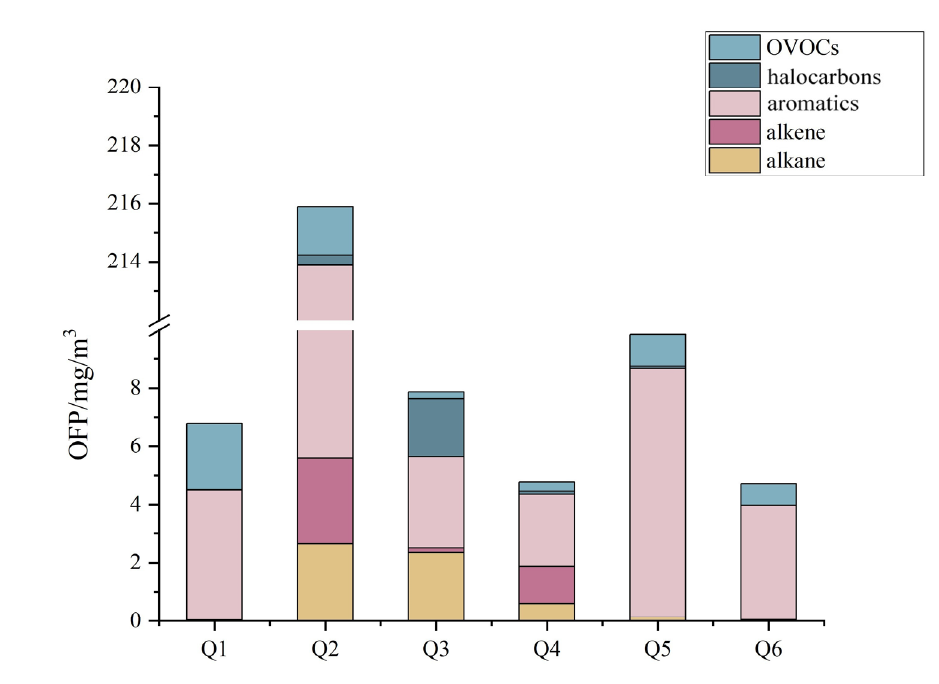
Figure 4. Contribution of different components to OFP.